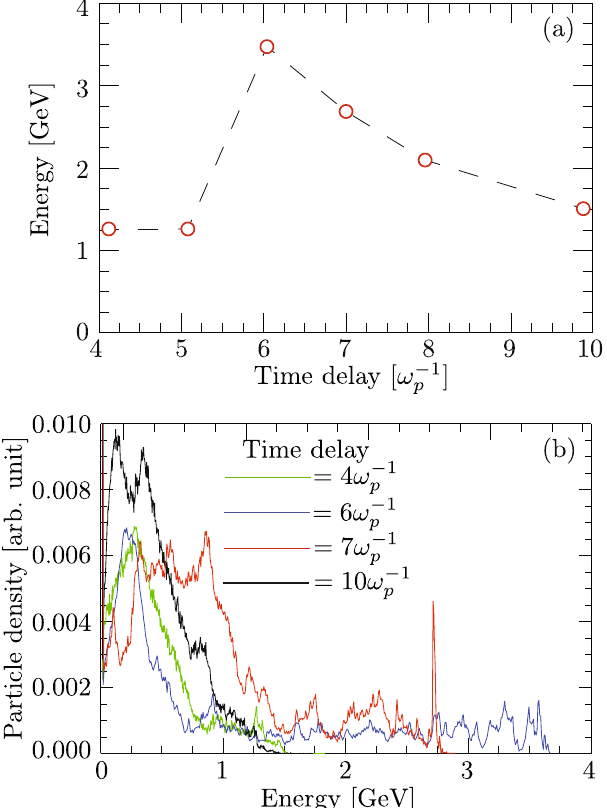
Figure 2. Effect of time-delay between the leading and trailing laser pulse on the electron energy. ( a ) Variation in the maximum energy with the time delay, and ( b ) spectrum of accelerated electrons by TFTP with time delay = 4 (green), 6 (blue), 7 (red), and 10 (black). The results are obtained with 2D PIC simulations. ω p t d